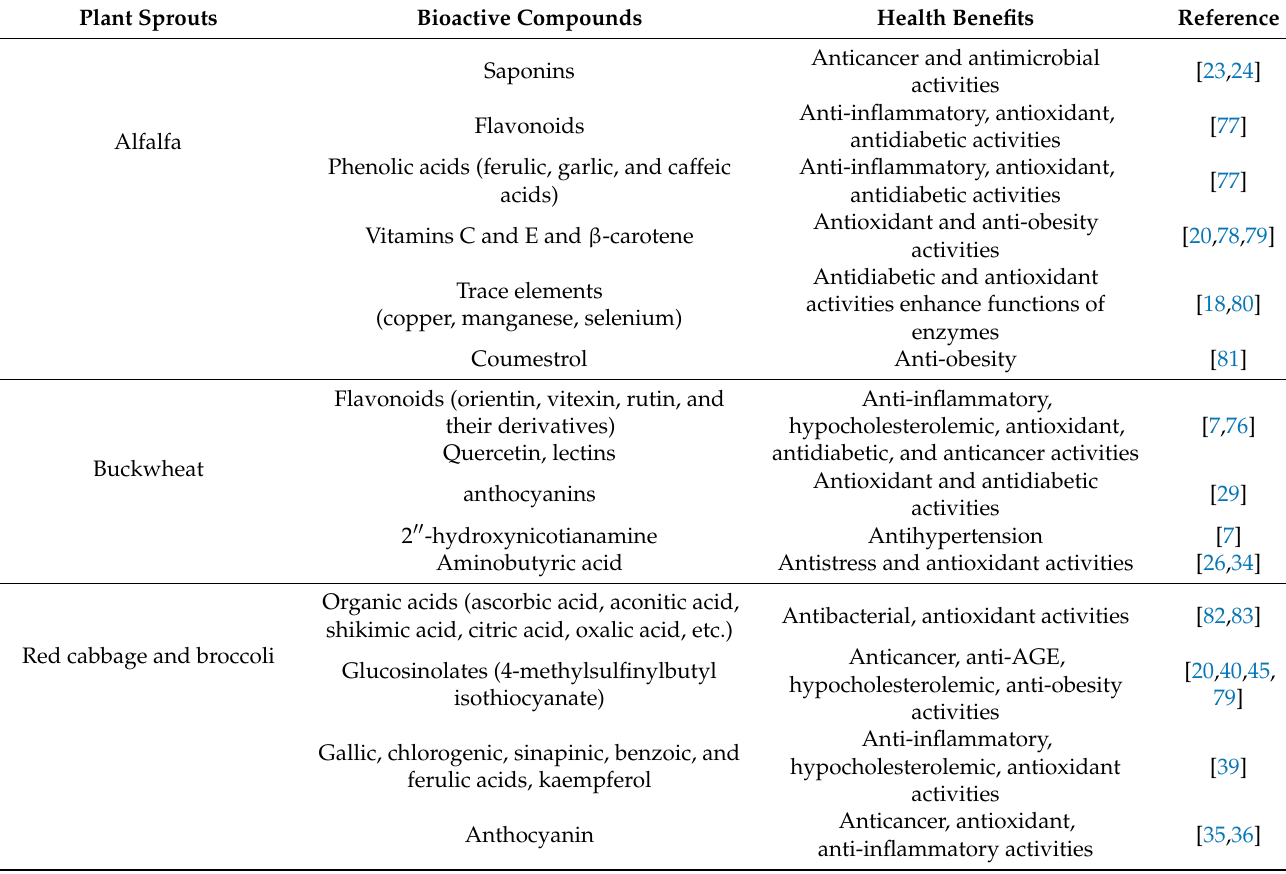
Table 1. Summary of major bioactive compounds in alfalfa, buckwheat, broccoli, and red cabbage sprouts. Plant sprouts